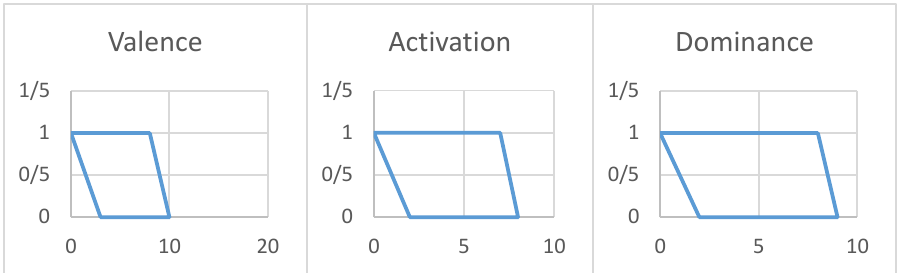
Fig. 10. The FOU of Ujo (Fear) for dimensions valence, activation and